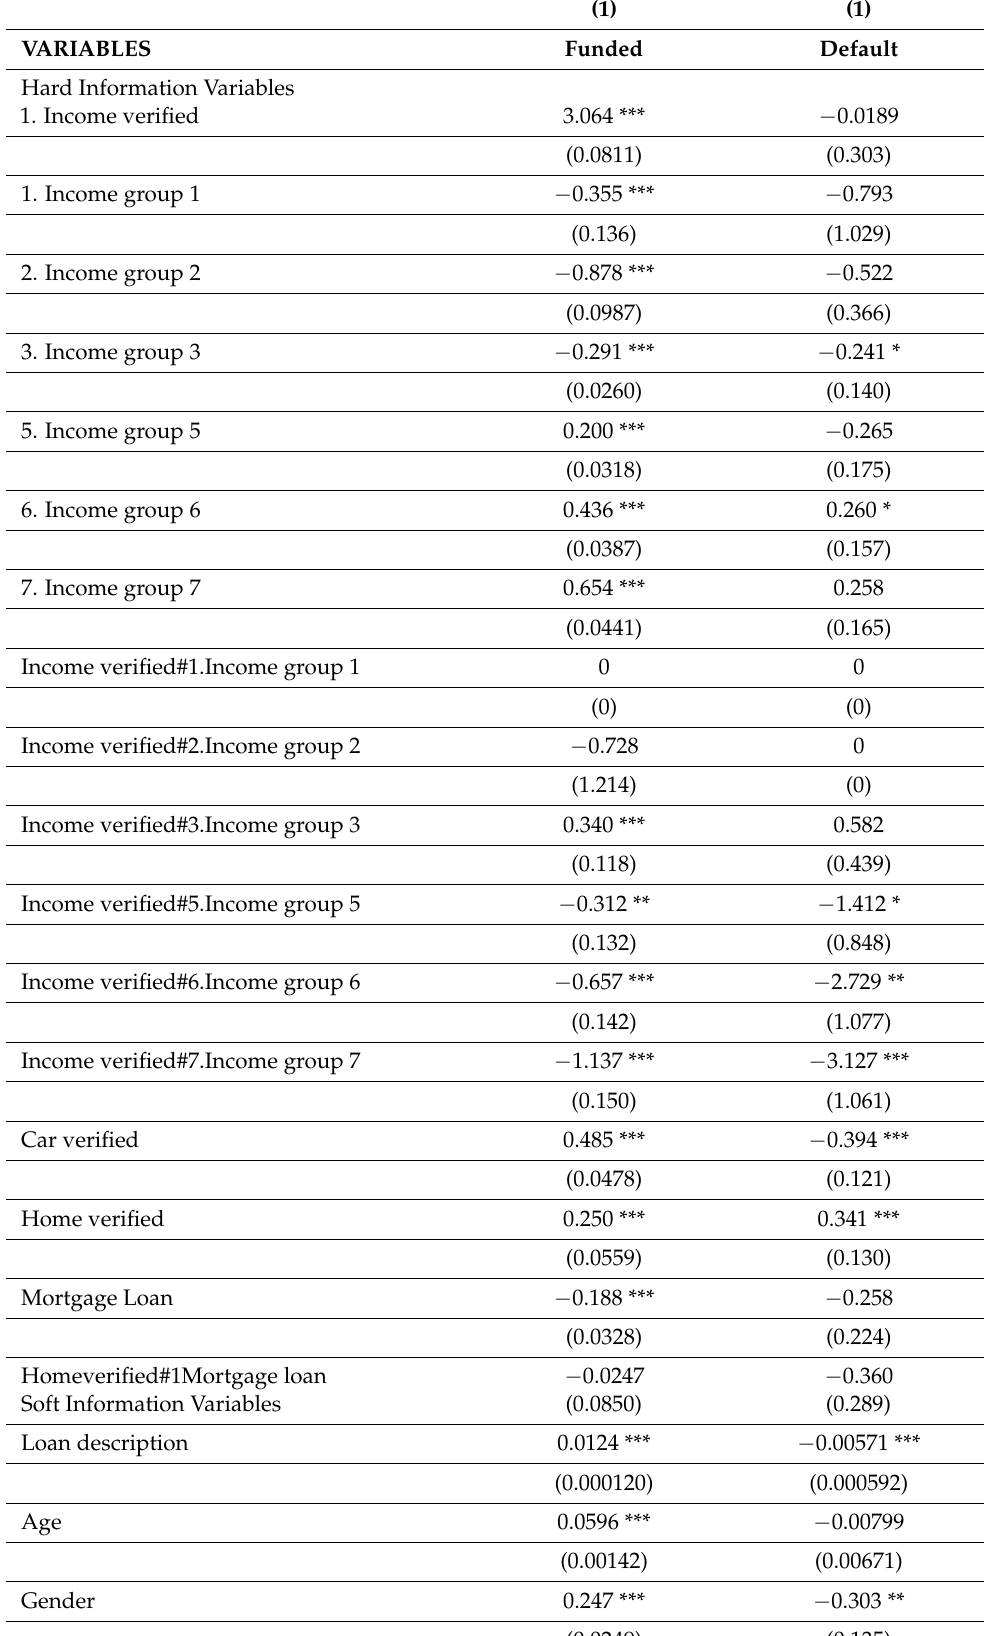
Table A4. Robustness Test with Region and Year